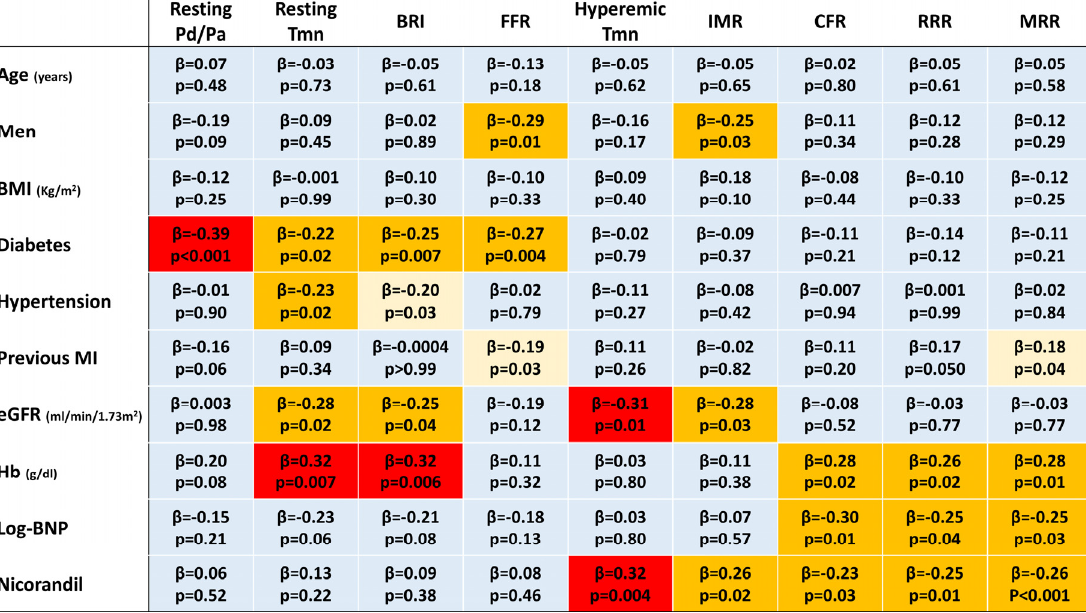
Figure 4. A heat map for multivariable linear regression analyses. A cell in light blue indicates no significant association ( p ≥ 0.05). When significant associations are found ( p < 0.05), cells are displayed in light ( − 0.20 ≤ β ≤ 0.20) or warm yellow ( − 0.30 ≤ β < − 0.20 or 0.20 < β ≤ 0.30) or red ( β < − 0.30 or β > 0.30). BMI, body mass index; BNP, brain natriuretic peptide; BRI, baseline resistance index; CFR, coronary flow reserve; eGFR, estimated glomerular filtration rate; FFR, fractional flow reserve; IMR, index of microcirculatory resistance; MI, myocardial infarction; MRR, microvascular resistance reserve; Pd/Pa, ratio of distal coronary pressure to aortic pressure; RRR, resistive reserve ratio; Tmn, mean transit time.